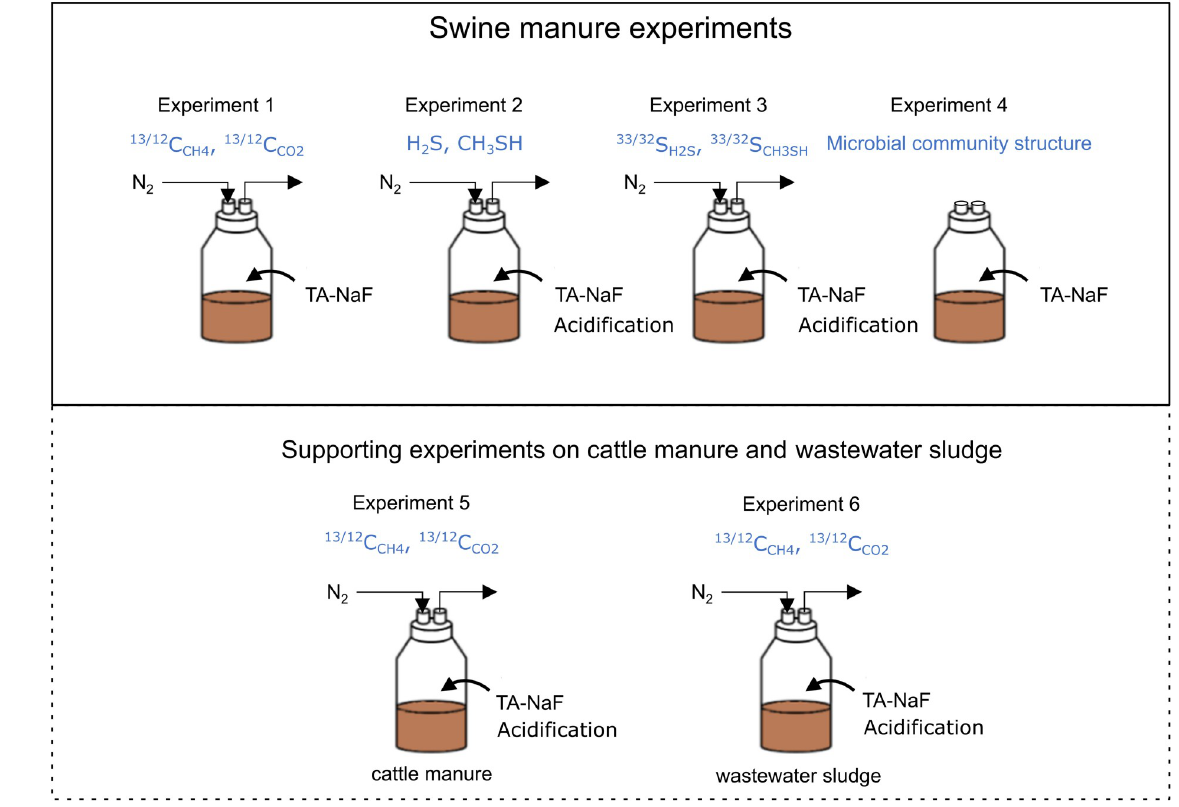
Fig 1. Overview of experiments conducted in this study. Blue text indicates the measured components. The inocula were treated with tannic acid with sodium fluoride (TA-NaF) or acidified with sulfuric acid or hydrochloric acid. Experiment 4 was carried out with both swine and cattle